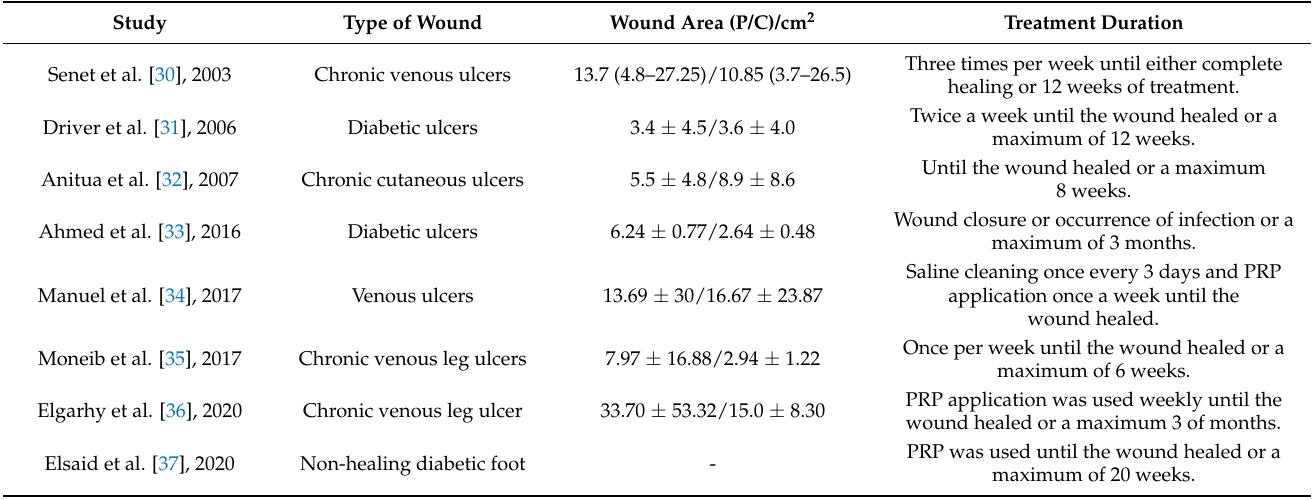
Table 2. The types of chronic wounds and treatment duration in all investigated studies. P represents the PRP group. C represents the normal saline group.